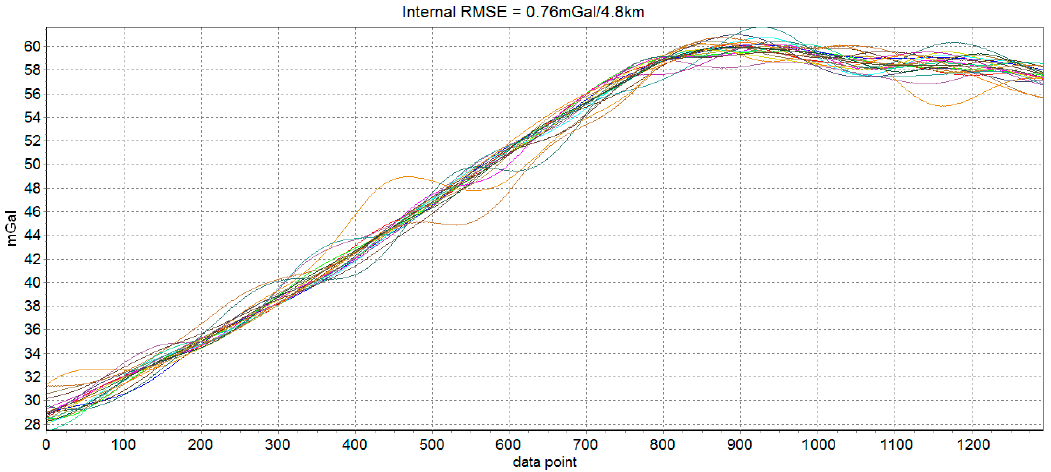
Figure 6. Measurement result of 21 quality assessment lines. Sensors 2018 , 18 , x FOR PEER REVIEW